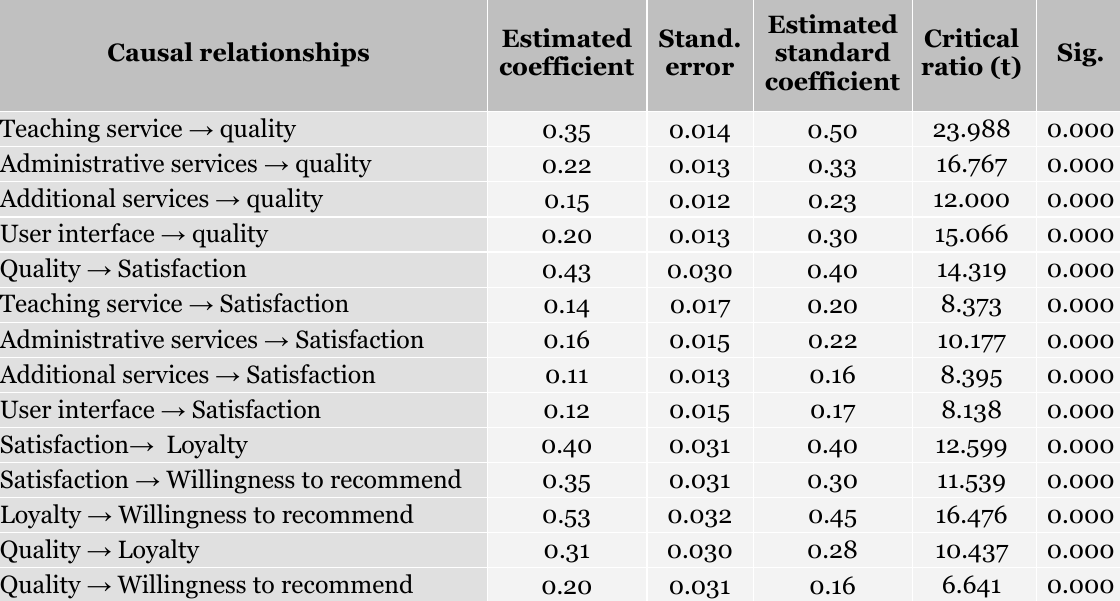
Relationship Between Variables: Model